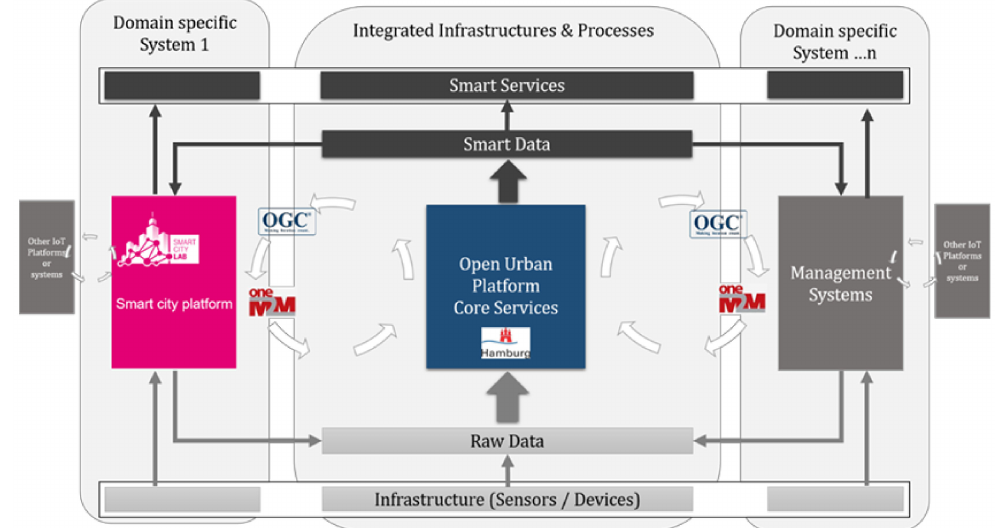
Figure 7. Adapted graphic of DIN Spec 91357 towards an Open Standard-based Urban Platform of Hamburg in mySMARTLife. It follows a “system of systems” according EIP SCC (European Innovation Partnership on Smart Cities and Communities) ensuring full interoperability using standardized APIs and connectors from OGC (Open Geospatial Consortium) and